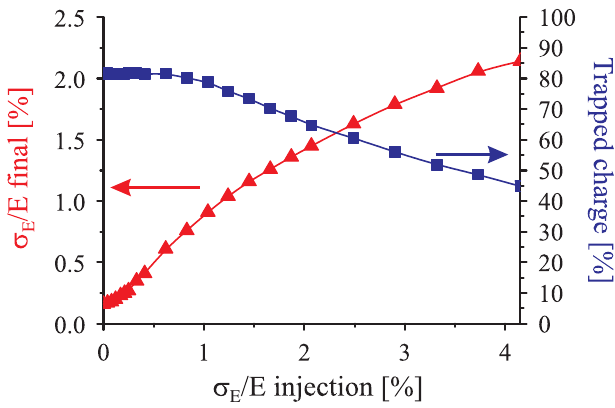
FIG. 11. (Color) Effect of the initial energy spread of injected electrons on the energy spread and trapped charge of the com- pressed bunch.